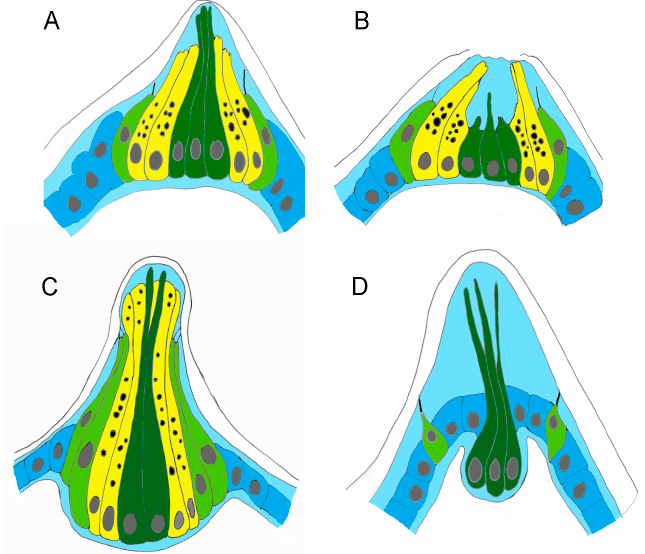
Figure 5. Schematic illustrations of adhesive papillae. ( A ) Swimming larva before metamorphosis of H. roretzi . ( B ) Adhering larva at the onset of metamorphosis of H. roretzi . ( C ) C. intestinalis swimming larva (redrawn from Zeng et al., 2019). ( D ) B. schlosseri swimming larva (redrawn from Caicci et al., 2010). Colour code: dark blue, ectodermal cells; dark green, ACCs; light blue, inner compartment of the tunic; light green, PSNs; yellow, CCs.